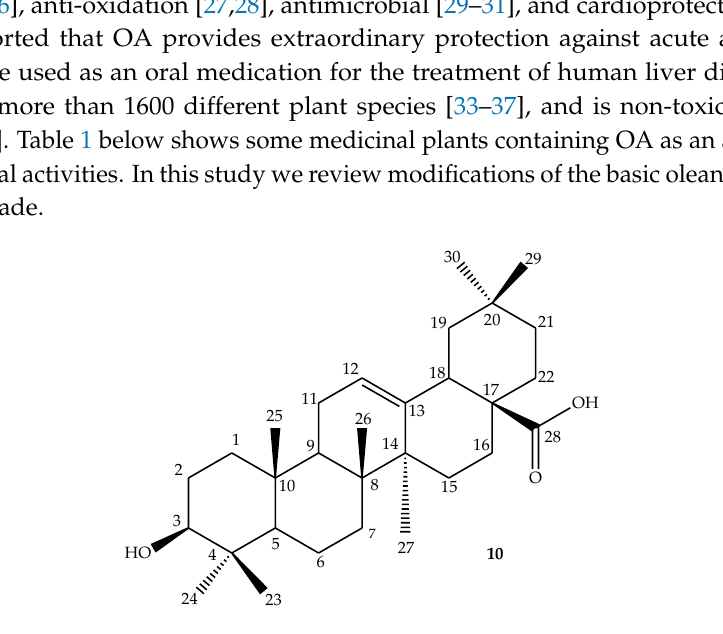
Figure 3. Structure of oleanolic acid (OA).